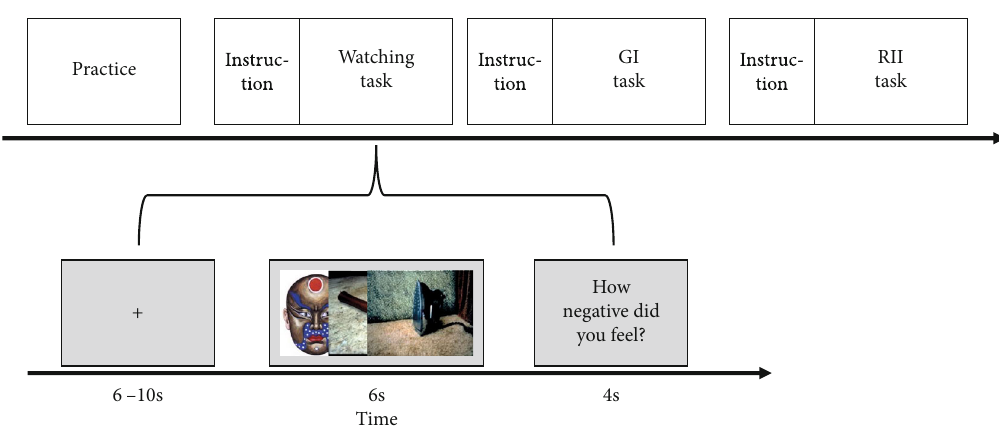
Figure 1: Experimental design for three tasks. The experiment consisted of three tasks, and each task consisted of fi ve neutral and fi ve negative blocks. “ How negative did you feel? ” rating ( 0 = notat all to 2 = moderately to 4 = extremely ) appeared at the end of each block. GI: goal intention; RII: reappraisal-based implementation